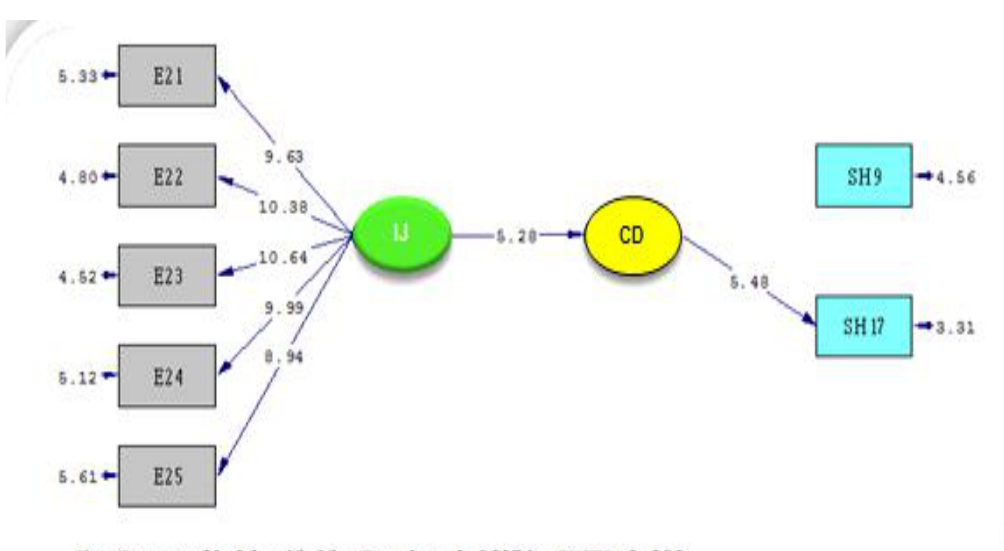
Fig. 7: Confirmatory Factor Analysis of Second sub hypothesis of the Research (Standard Estimation Numbers)